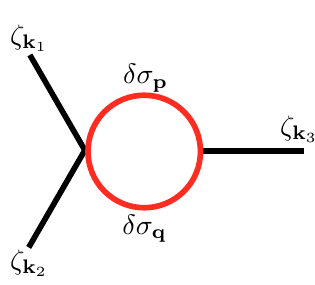
Figure 12 . The Feynman diagram we are considering for the loop correction to the